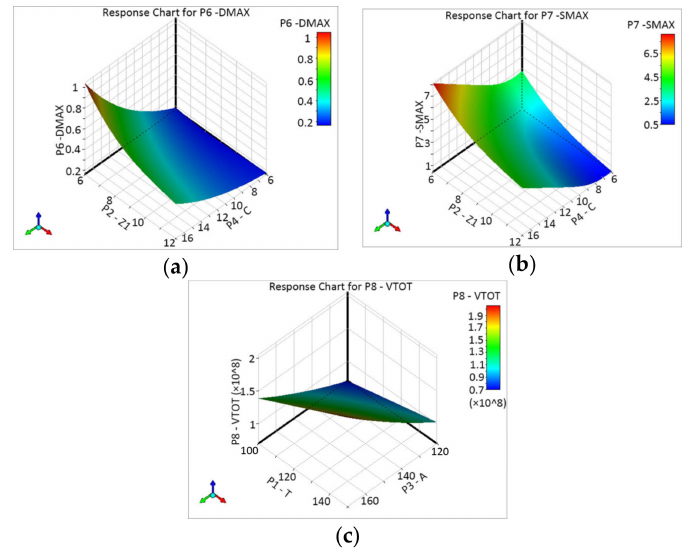
Figure 9. Surface response diagram between three variables: ( a ) Z 1 , C, and DMAX. ( b ) Z 1 , C, and SMAX. ( c ) T, A, and VTOT.